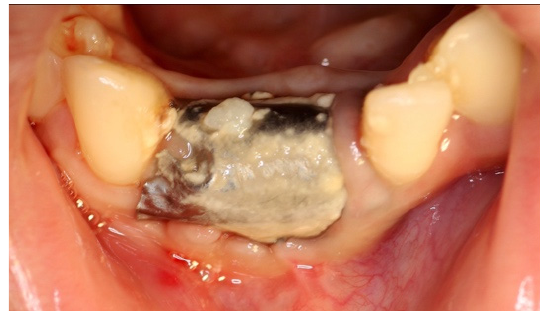
Figure 15. Accumulation of plaque on the foil.